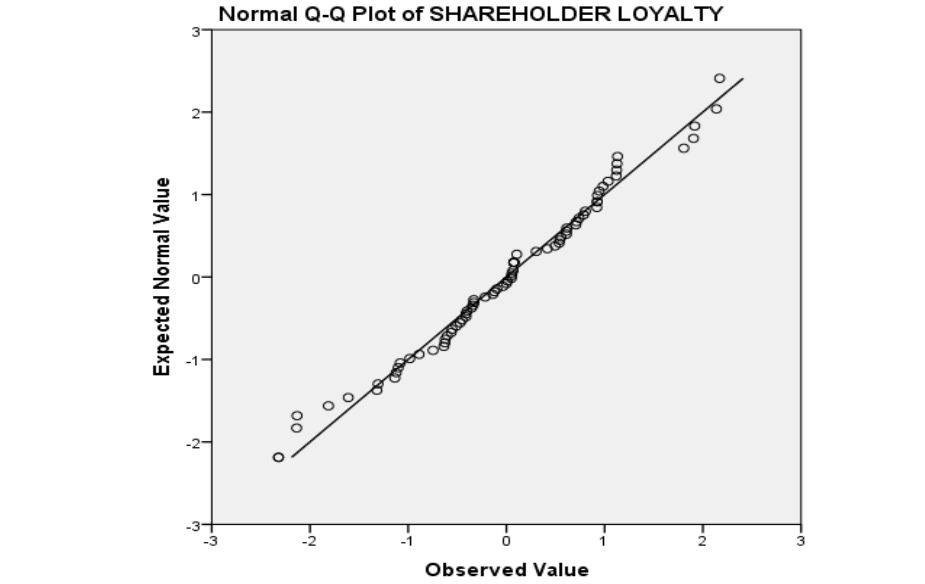
Figure 1: Normal Q-Q plot of shareholder loyalty